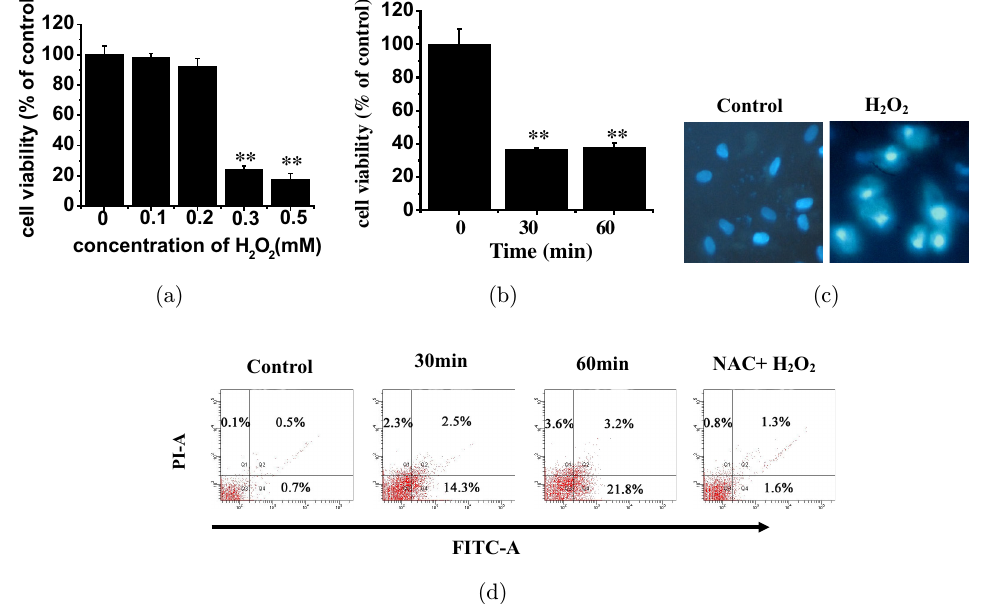
Fig. 1. H 2 O 2 induces apoptosis in rabbit chondrocytes. (a) H 2 O 2 induced concentration-dependent cytotoxicity assessed by CCK-8 assay. Cells were plated and treated with various concentration of H 2 O 2 for 2 h. Data are mean (cid:4) SD ( n ¼ 3; ANOVA: ** p < 0 : 01, compared with control cells). (b) H 2 O 2 induced time-dependent cytotoxicity assessed by CCK-8 assay. Cells were treated with 0.3mM H 2 O 2 for 0, 30 and 60 min, respectively. Data are mean (cid:4) SD ( n ¼ 3; ANOVA: ** p < 0 : 01, compared with control cells). (c) H 2 O 2 induced nuclear concentration of cells stained with Hoechst 33258. The cells were treated with 0.3 mM of H 2 O 2 for 30 min, and the nuclear morphology was detected by Hoechst 33258 staining and examined by °uorescence microscope. Magnification (cid:3) 400. (d) FCM analysis of H 2 O 2 -induced apoptosis by °uorescence-activated sorting analysis of Annexin V-FITC/PI. The cells treated with di®erent conditions were stained with 5 (cid:2) l of Annexin V-FITC and 10 (cid:2) l of PI (10 (cid:2) g/ml), respectively before being